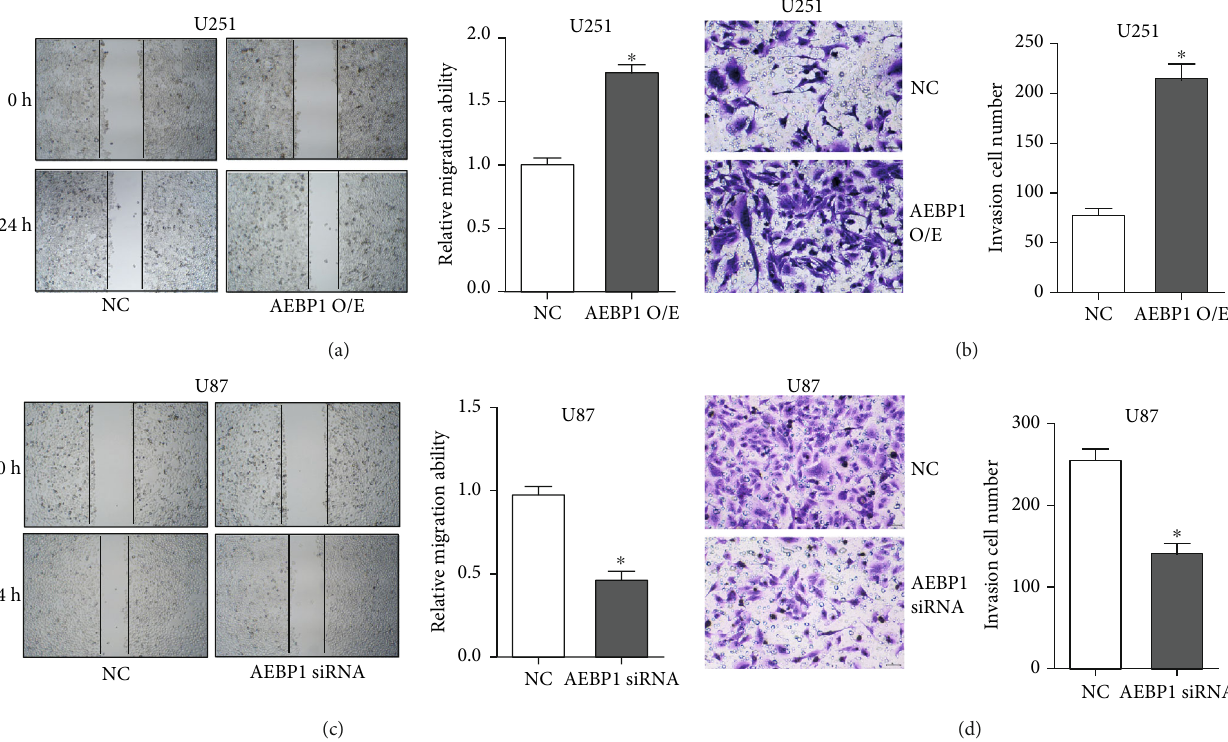
Figure 5: AEBP1 promoted GBM cell migration and invasion in vitro. The AEBP1 overexpression plasmid was transfected in U251 cells and AEBP1 siRNA in U87 cells: (a, c) cell migration was detected by the scratch assay; (b, d) cell invasiveness was assessed by the Transwell assay. N = 3 , ∗ P < 0 : 05 .